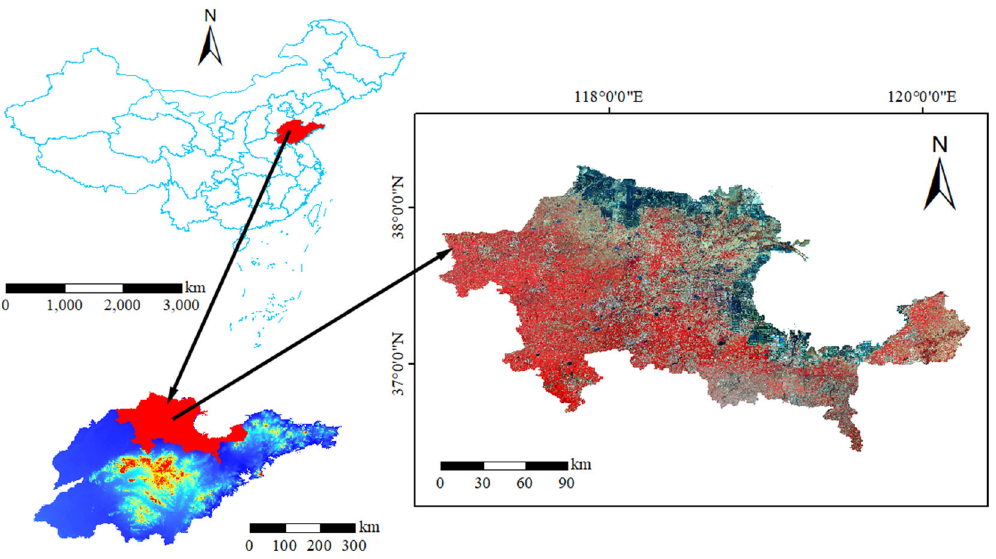
Figure 1. False color composite of the study area: Band8 (nir), Band4 (red) and Band3 (green) of Sentinel ‐ 2 MSI.